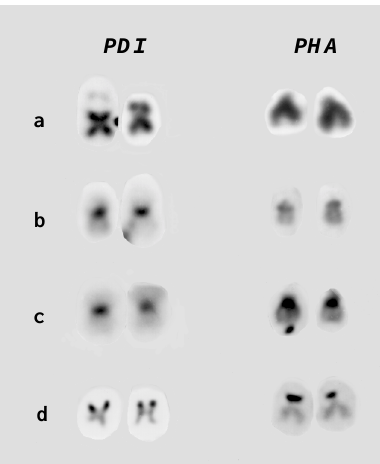
Figure 3 - Pair 15 of Phyllostomus discolor ( PDI ) and P. hastatus ( PHA ). a) Giemsa stained, b) G-banded, c) C-banded and d) Ag-NOR